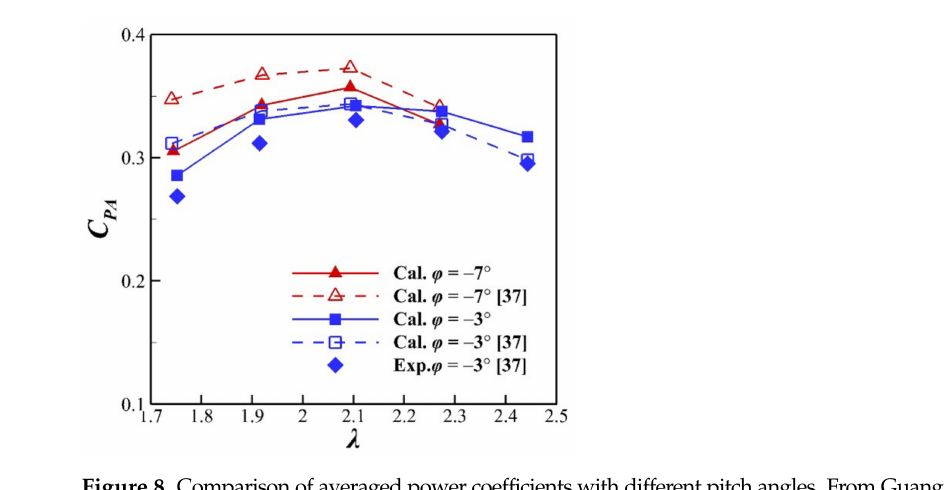
Figure 8. Comparison of averaged power coefficients with different pitch angles. From Guang, Z. et al. [37].